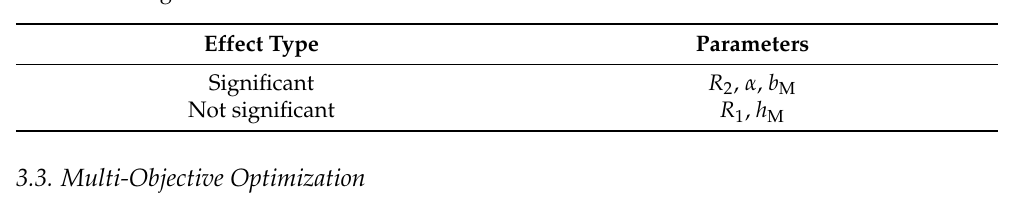
Figure 6. The Pareto chart and a normal plot. ( a ) The Pareto chart of the effects with response T em . ( b )The normal plot of the effects with response T em . ( c ) The Pareto chart of the effects with response k . ( d ) The normal plot of the effects with response k . Table 4. The significant factors of the